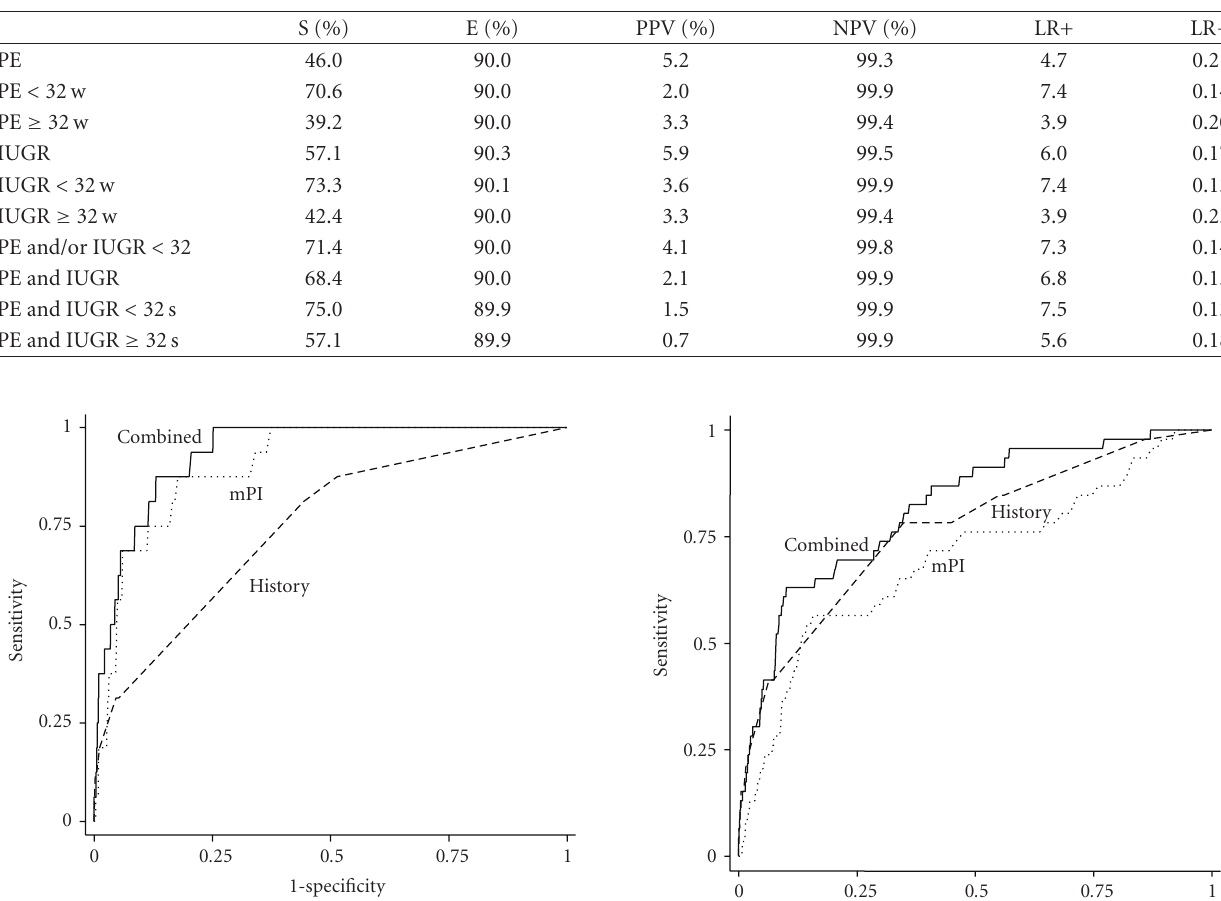
Table 3: Screening characteristics for mean PI > 1.40 irrespective of bilateral Notches at 20 w (screen positive rate: 10%).